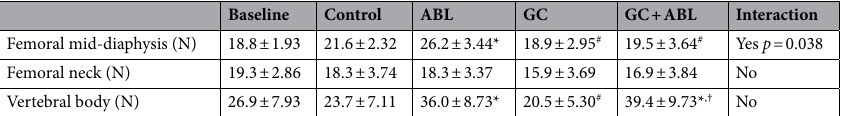
bone formative parameters at the periosteal femoral mid-diaphyseal bone surface. Neither GC nor ABL had any influence on the resorptive indicator Tetra.S/BS at the periosteal surface at the femoral mid-diaphysis (Fig. 4). At the endocortical bone surface, treatment with ABL did not influence any of the formative bone parameters assessed with dynamic bone histomorphometry in either Control or GC animals. Animals in the GC group had